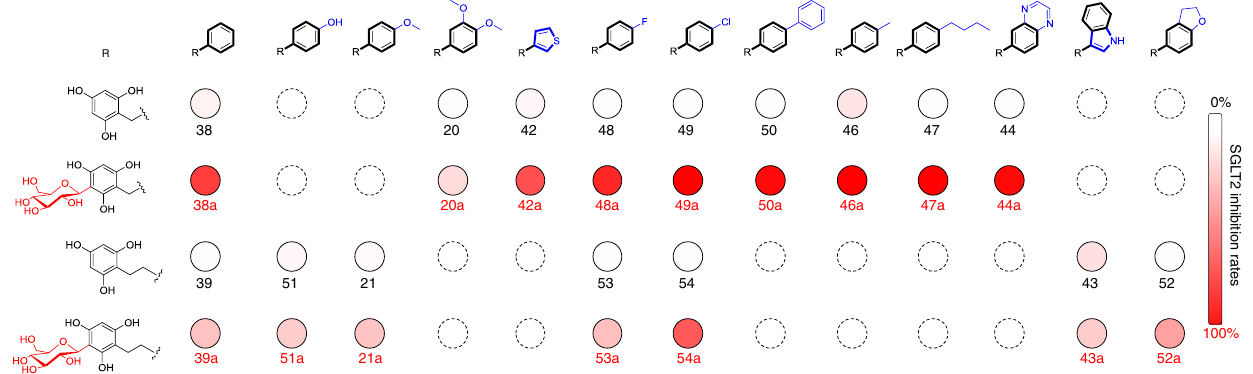
Fig. 3 SGLT2 inhibition rates of the designed aglycons and the corresponding C -glycosides. The shade of red fi lled circles represents the SGLT2 inhibition level with aglycons and C -glycosides at 10 μ M. The depth of red color represents the SGLT2 inhibition rate. Experiments were performed in